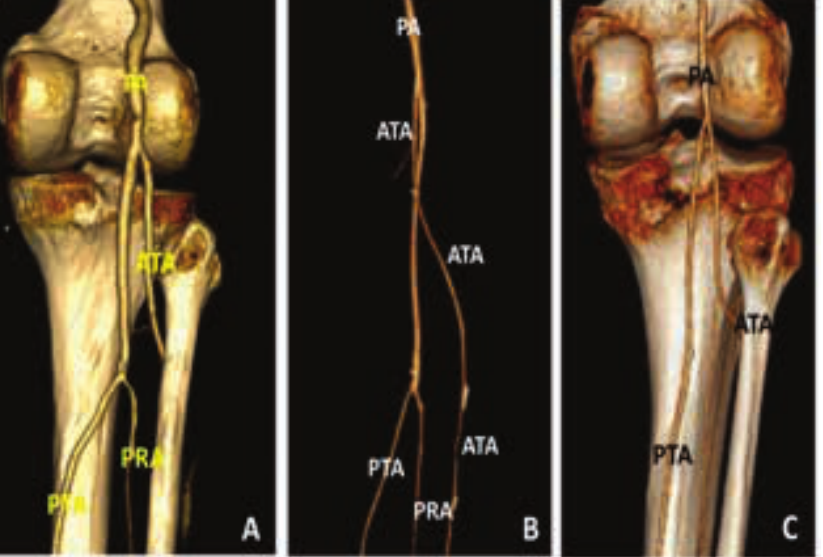
Figure 3: The VR MDCT images in the right lower extremities show the Type II branching pattern of the PA above the normal level. Type IIA (1) pattern with normal proximal course of ATA is depicted in (A); (B) shows Type IIA (2) pattern with proximal and medial course of ATA. Type IIB pattern is seen (C); branching of PTA is at the joint level, and branching of ATA and PRA from the tibioperoneal